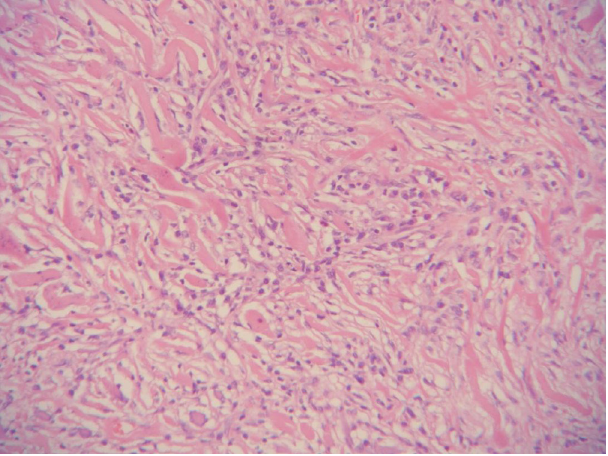
Fig. 4 – Haphazardly arranged collagen lamellae separated by an inflammatory